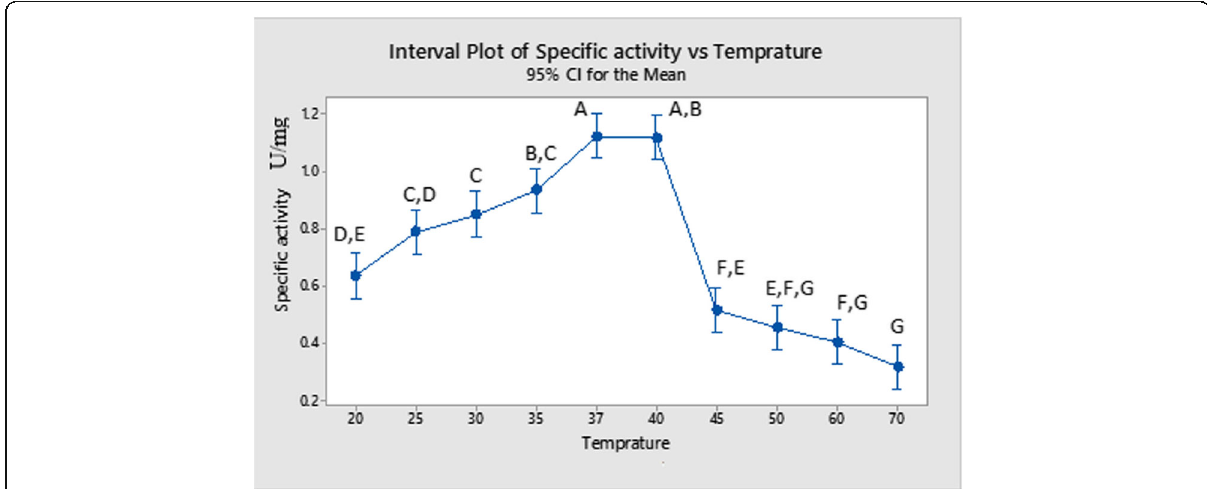
Fig. 6 Effect of temperature (°C) on activity of purified fat body lipase from larvae of G. mellonella by using different temperature range. Different letters indicate significant differences ( p < 0.05), (no. of replicates =